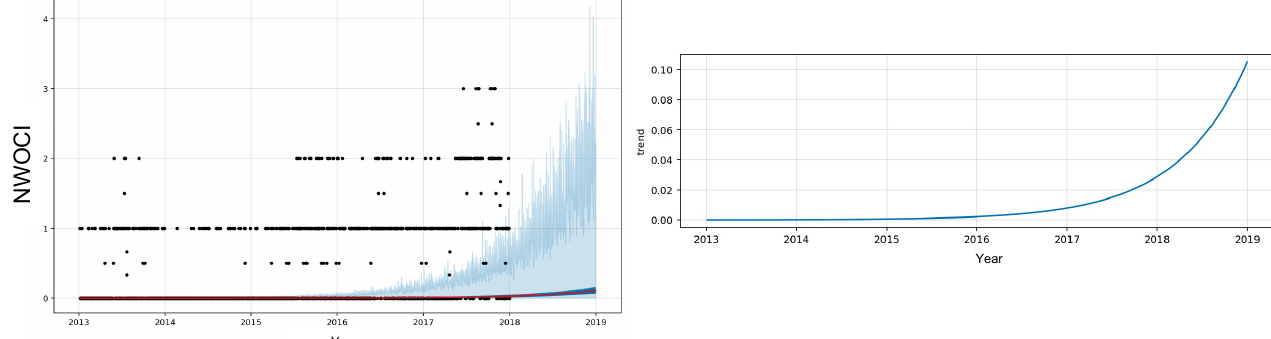
Figure A7. Left : One year forecast (2018 test data) from Prophet-BU Model for Hamphsire county in MA. N.B: The solid blue line shows the average forecast while the solid red line shows the observed trend of NWOCI and the light blue region represents the 80% confidence interval for the forecast uncertainty. Also, the scatter points represent the historical values in the training data (2013–2017). Right : Corresponding trend decomposition from Prophet-BU